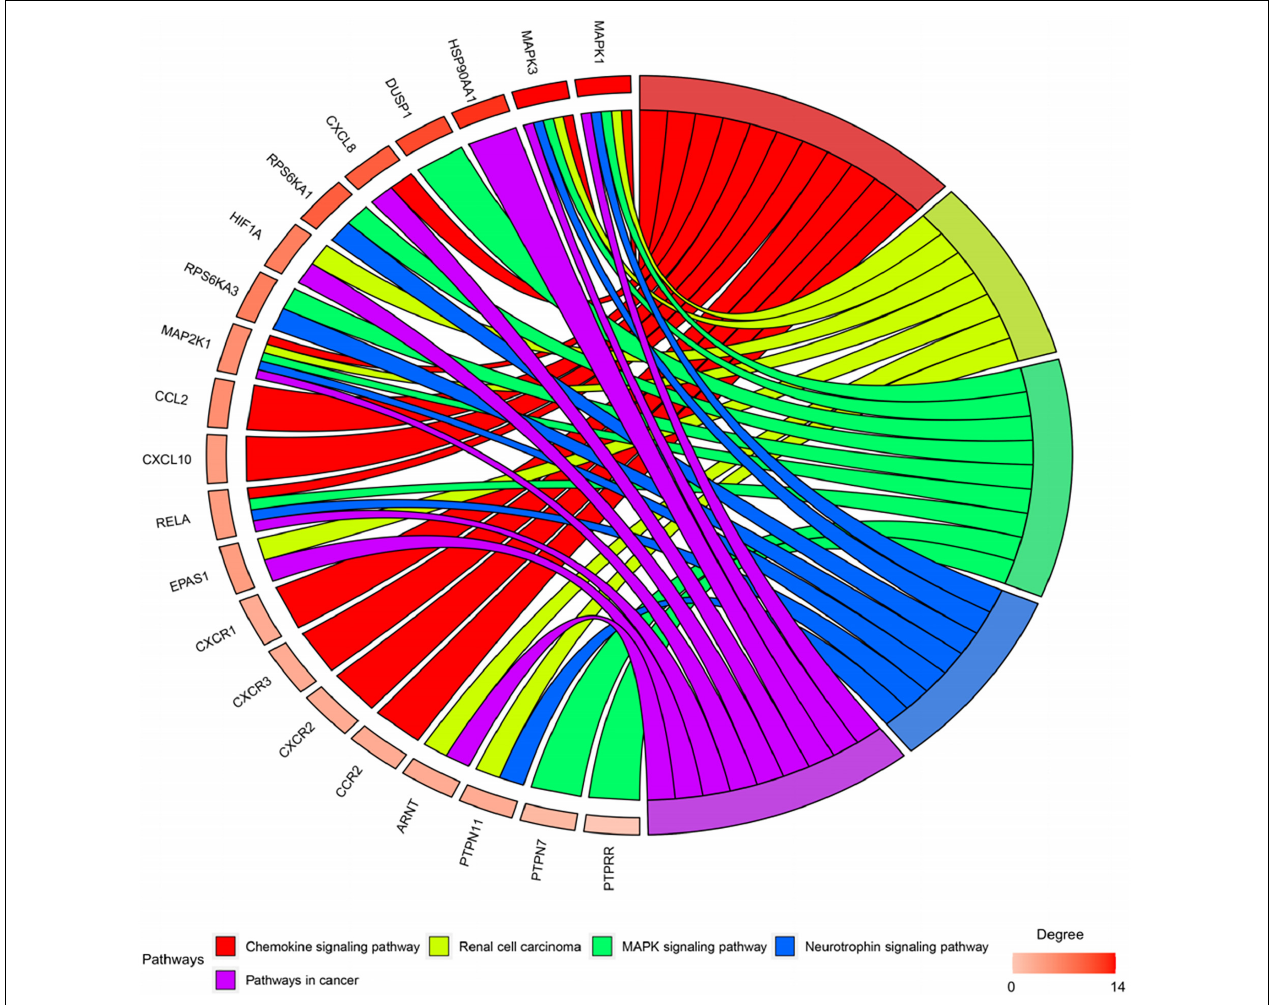
FIGURE 4 | Gene enrichment analysis. MAP2K1, MAPK1, and MAPK3 were involved in all five pathways. The sub genes by degree were MAPK1, MAPK3, and MAP2K1.